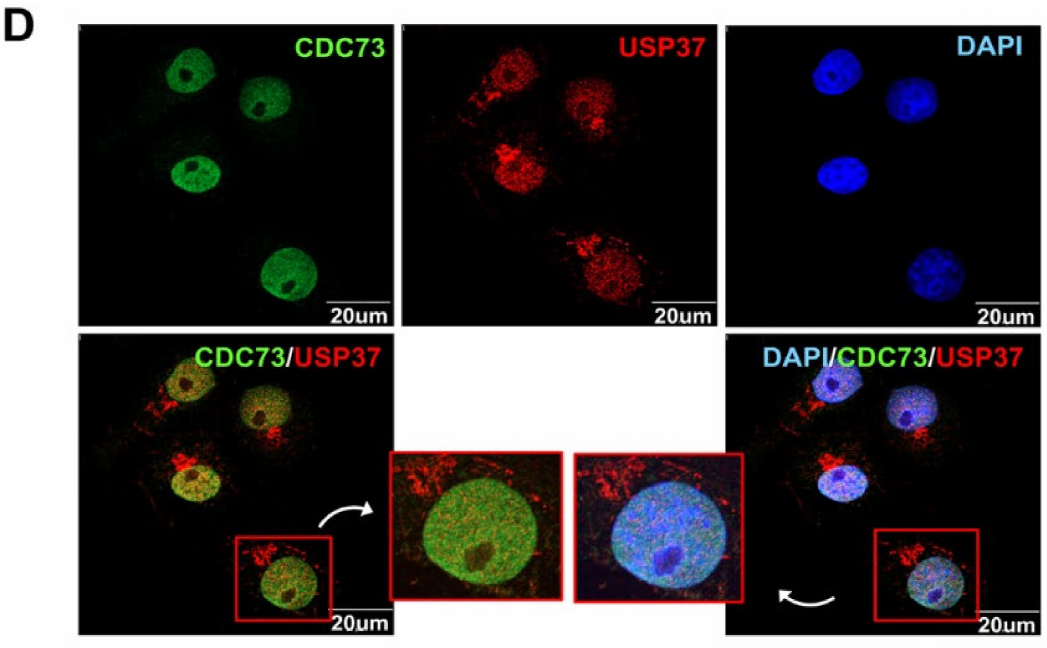
Figure 5. Identification of the binding sites in CDC73 and USP37. Schematic description of the USP37 and CDC73 deletion constructs ( A ). Western blotting results after immunoprecipitation of lysates of COS7 cells transfected with full-length FLAG-CDC73 and Myc-full-length USP37 and deletion constructs ( B ) and vice versa ( C ). Full-length CDC73 binds to full-length USP37, and USP37 ∆ 3 and ∆ 4 containing ubiquitin-interacting motifs (UIM) 2 and 3. Conversely, full-length USP37 binds to full-length CDC73, and ∆ 1, ∆ 2 and ∆ 5 containing the β -catenin binding region. Nuclear co- localization of CDC73 and USP37 is shown by the yellow (green + red) nuclear immunofluorescence staining in lysates of COS7 cells transfected with full-length FLAG-CDC73 and Myc-USP37 ( D ). PH; pleckstrin homology; UCH, ubiquitin carboxyl-terminal hydrolase; UIM, ubiquitin-interacting motif; NLS; nuclear localization signal; IP, immunoprecipitation; WCL, whole cell lysate; DAPI, 4 (cid:48) ,6-diamidino-2 (cid:48) -phenylindole